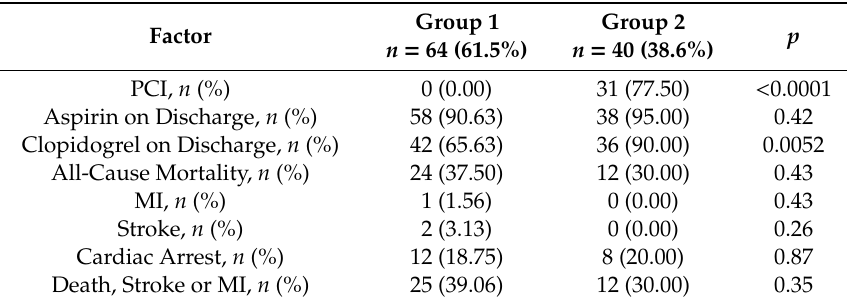
Table 2. Management and in-hospital outcome.